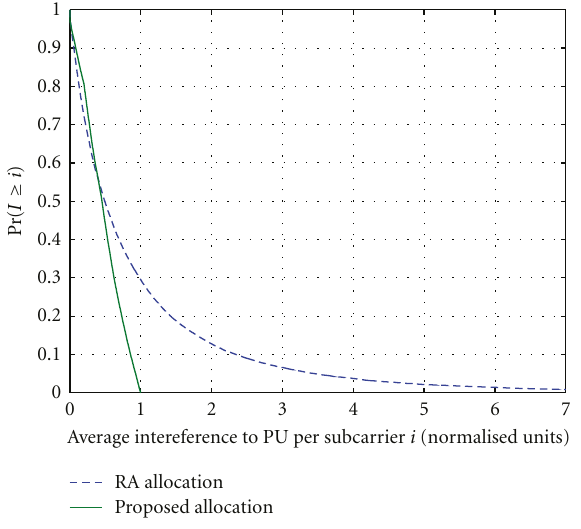
Figure 5: Complementary cumulative distribution function of interference power to primary rx, with the IPC set to 1 on each subcarrier in the proposed scheme. Figure 6: Rate-distortion characteristics of di ff erent sequences considered in the